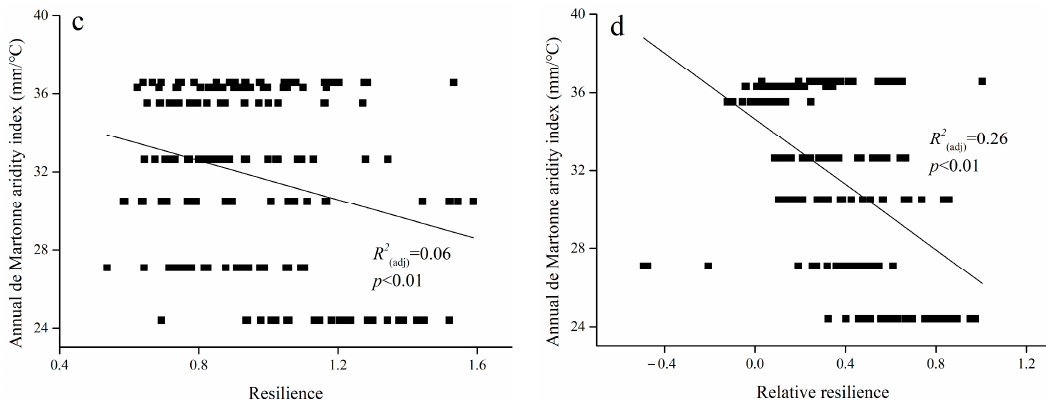
Figure 6. The linear relationships between the stable indices (( a ): Resistance, ( b ): Recovery, ( c ): Resilience, ( d ): Relative resilience) and the annual de Martonne aridity index.